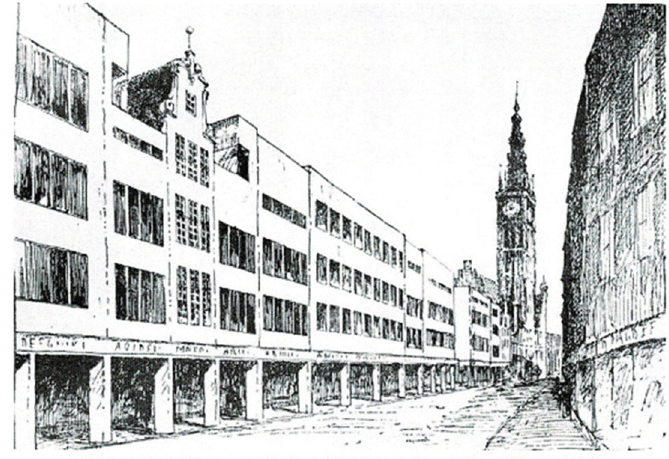
Figure 5. Frontage of D ł uga Street in Gda ń sk designed by Martin Kiessling [48].